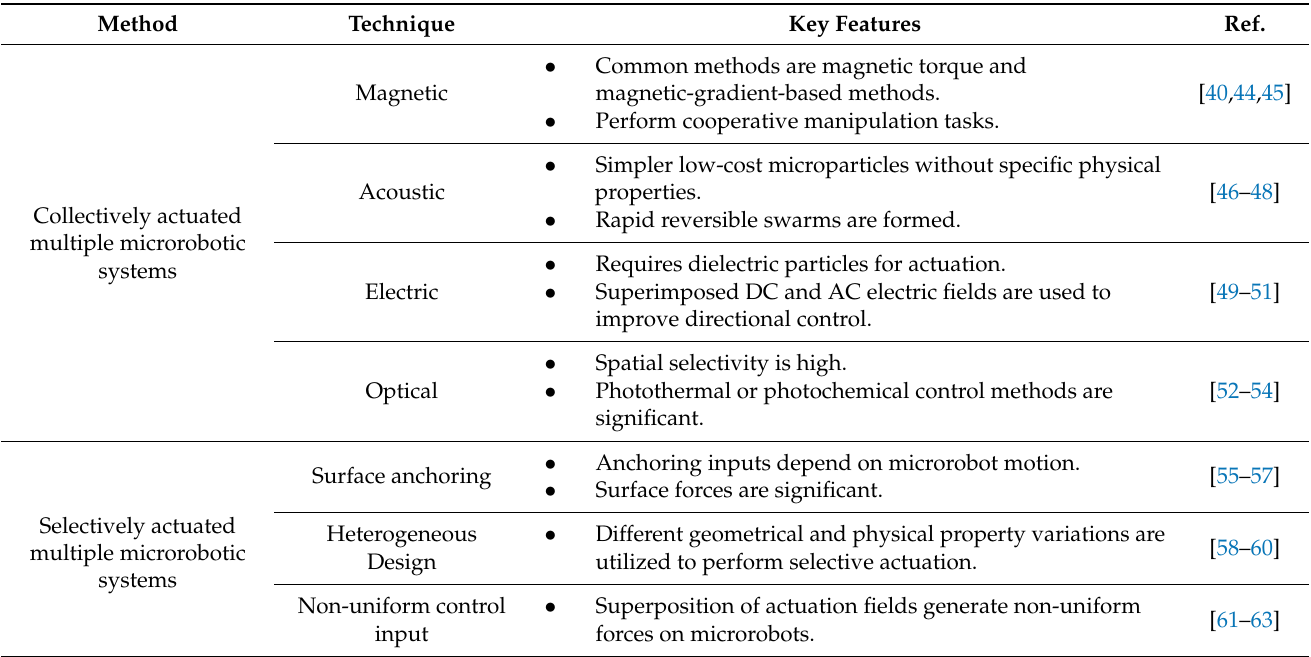
Table 1. Key features of different shape forming